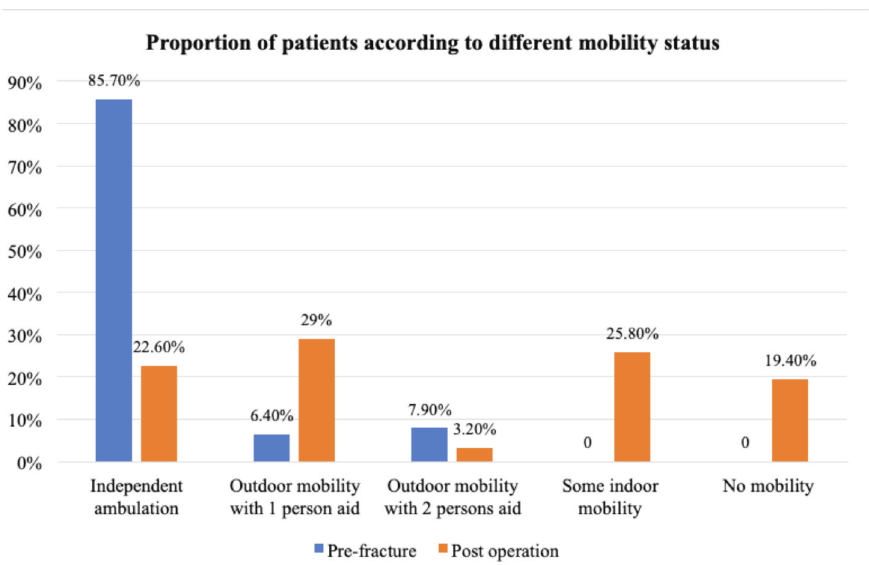
Comparison of patients’ mobility status between pre-fracture and post-operative Fig. 2: